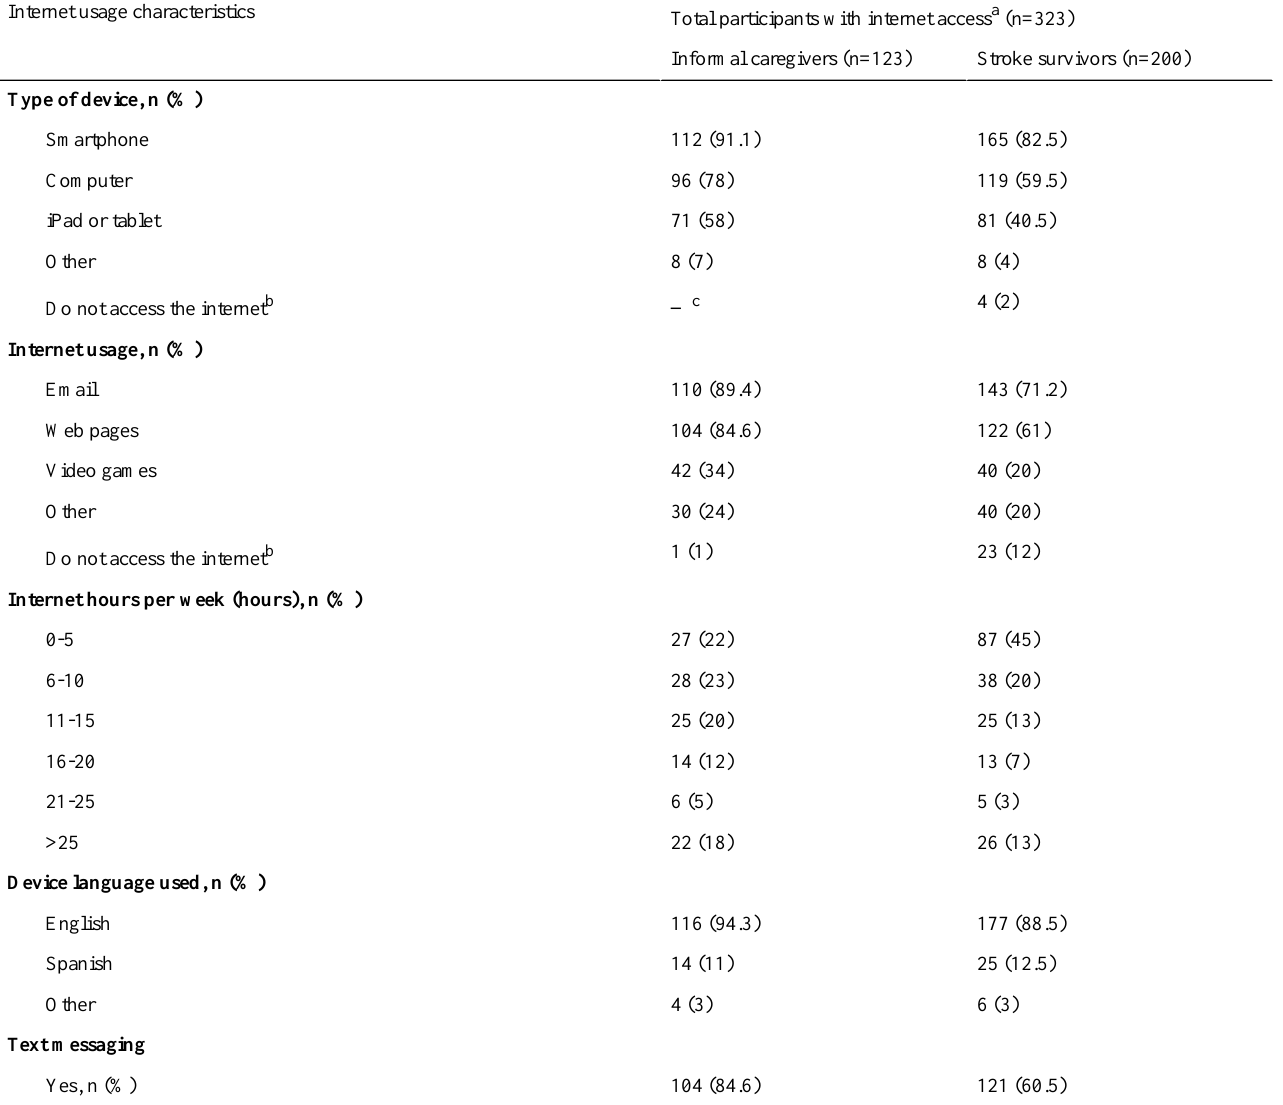
Table 2. Internet usage characteristics of stroke survivors and informal